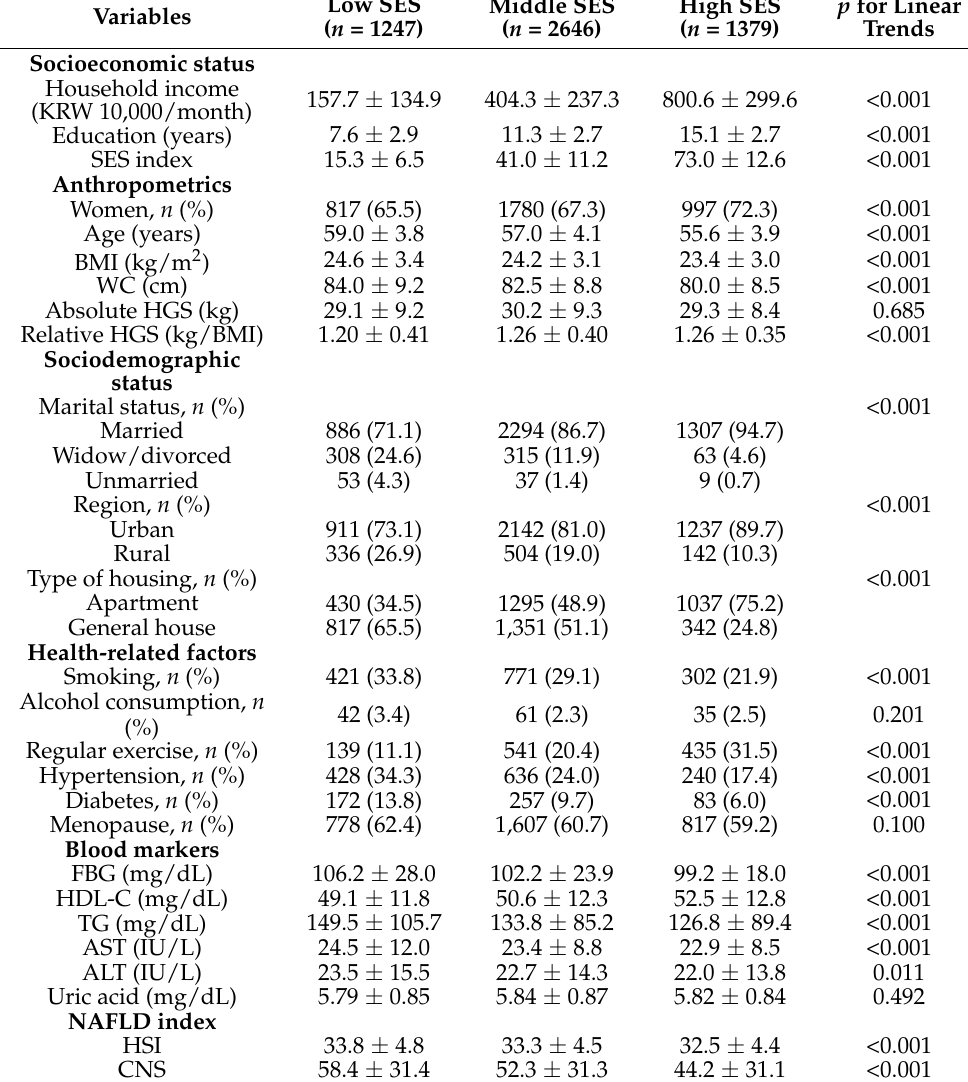
Table 2. Descriptive statistics of the measured parameters according to SES categories.